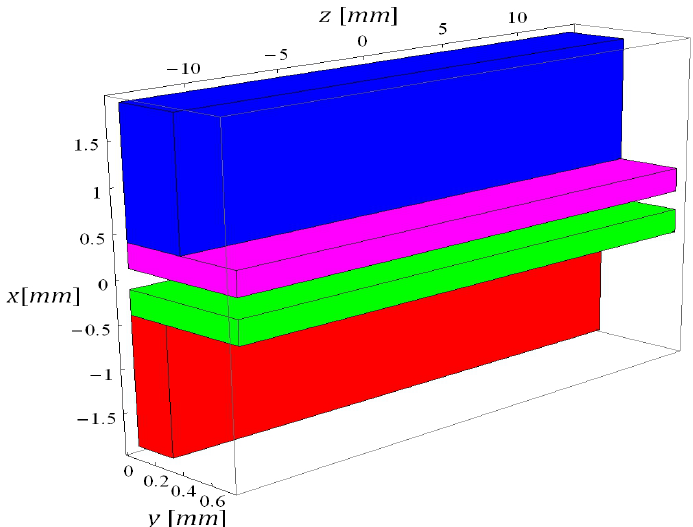
Figure 6. Representative unit in coordinate system. Cathode channel is coloured blue, cathode GDL magenta, anode GDL green and anode channel red. The central symmetry plane of a rib and the symmetry plane between ribs (respectively depicted as green and yellowish surfaces in Figure 1) that define representative unit are at y = 0 and at y = 0.75 mm respectively. Anode and cathode inlets are at, z = − 13.5 mm outlets at z = 13.5 mm and the cross-sectional plane midway between inlet and outlet is at z =